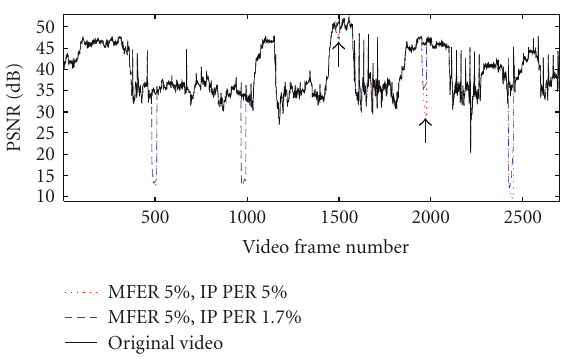
Figure 6: PSNR video quality results in MFER 5% with 1.7% and 5.0% IP packet error ratios.